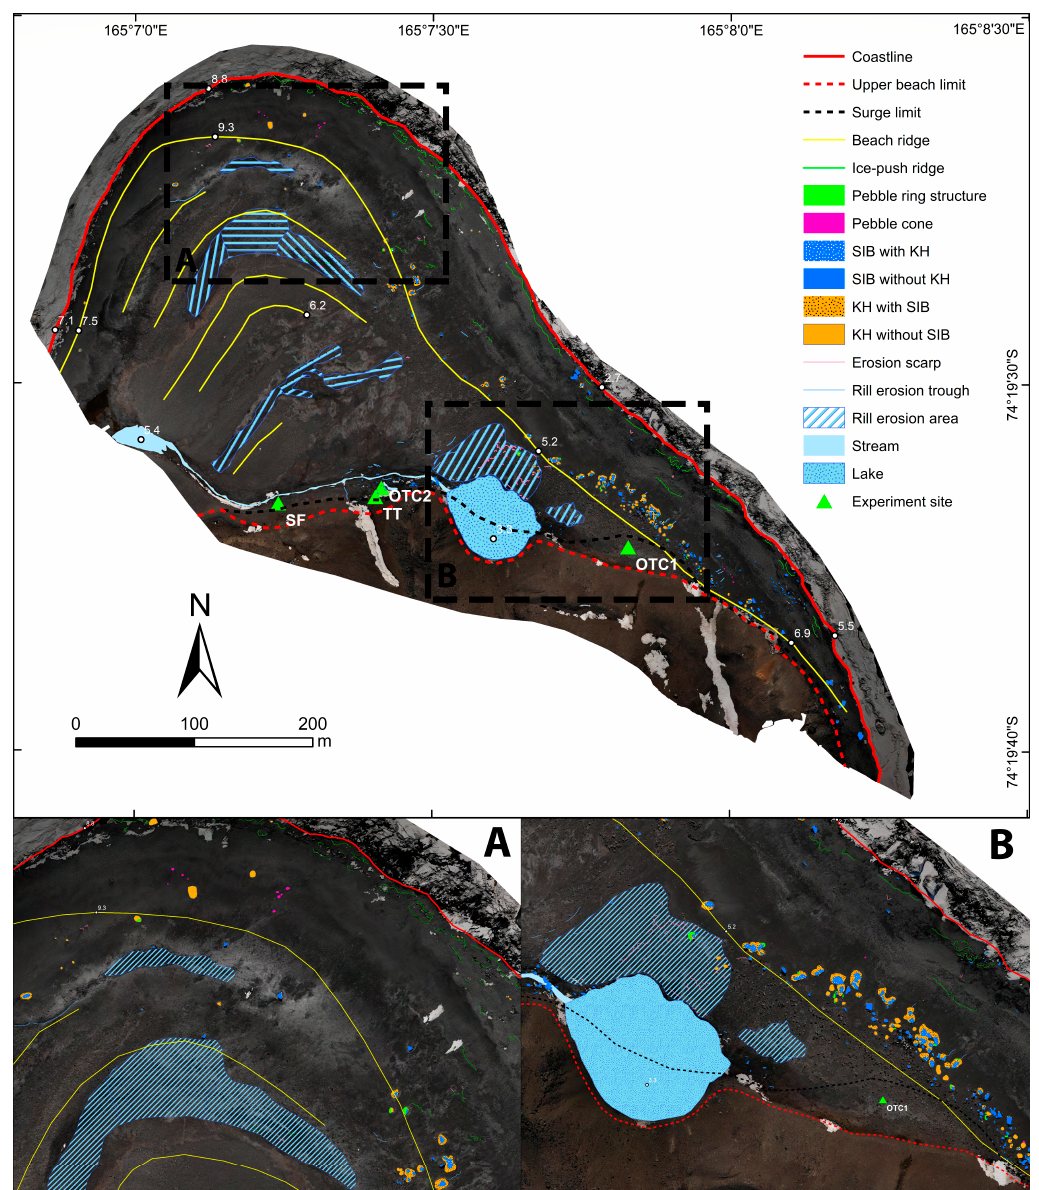
Figure 2. Geomorphological map of EPNB drawn upon the orthophoto obtained through the helicopter images. SIB = sea- ice block, KH = kettle hole. SIB with KH and KH with SIB are kept separately in order to differentiate their morphometry in the next section. The experiment sites show the positions of 2 open top chambers (OTC1-2), the precipitation shield (TT) and the snow fence (SF). Please note that “Coastline” refers to maximum extension of sea-ice that might not coincide with the real coastline. The rill erosion area symbol (oblique lines) matches the real orientation of the landforms.